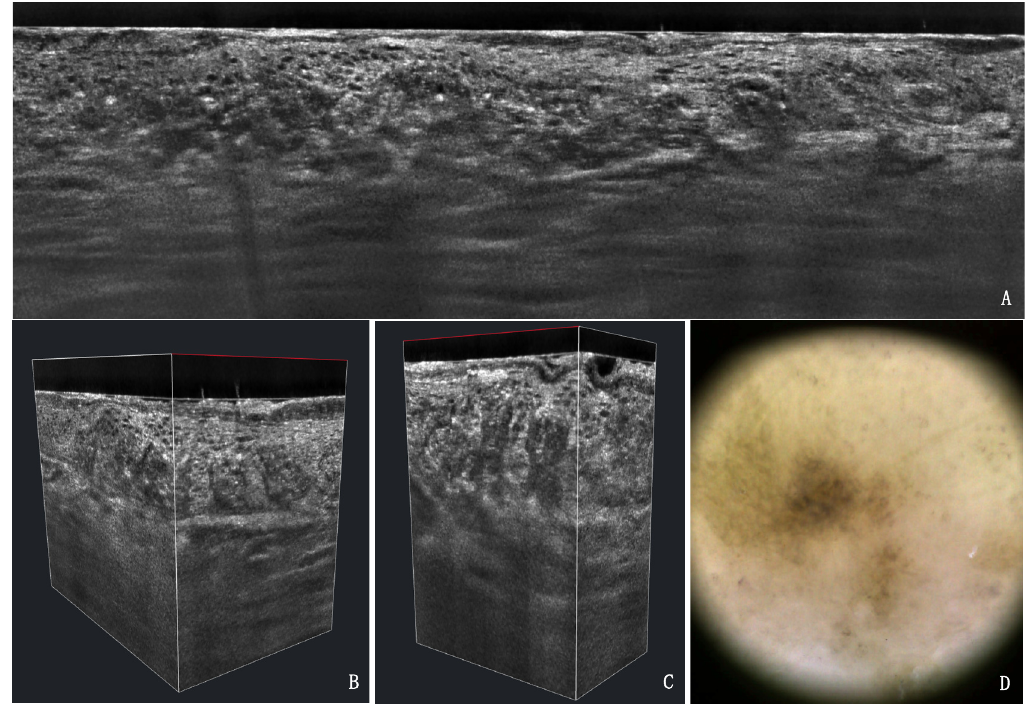
Figure 5. LC-OCT vertical ( A ), 3D ( B , C ) and dermoscopy ( D ) of a pigmented PRO III AK lesion on the dorsum of the hand of an 82-year-old male patient. The typical papillary sprouting as well as the pigmented basal keratinocytes are visible.